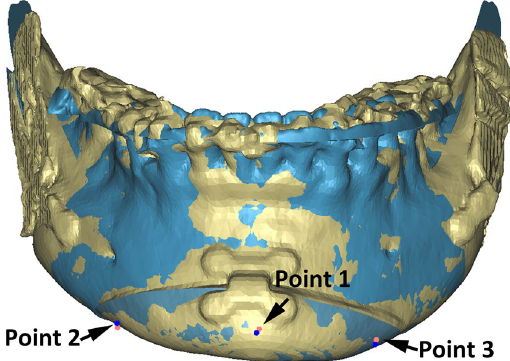
Figure 3. Three corner points of the chin segment were digitized on both planned and postoperative models to define the position and orientation of the chin segment. The landmarks utilized were: the pogonion (Point 1) and bilateral corner point on the buccal surface of the chin segment (Point 2 and Point 3). The landmarks on the planned models were marked in red, and the landmarks on the postoperative models were marked in blue. The planned models were showed in blue, and the postoperative models were showed in yellow.